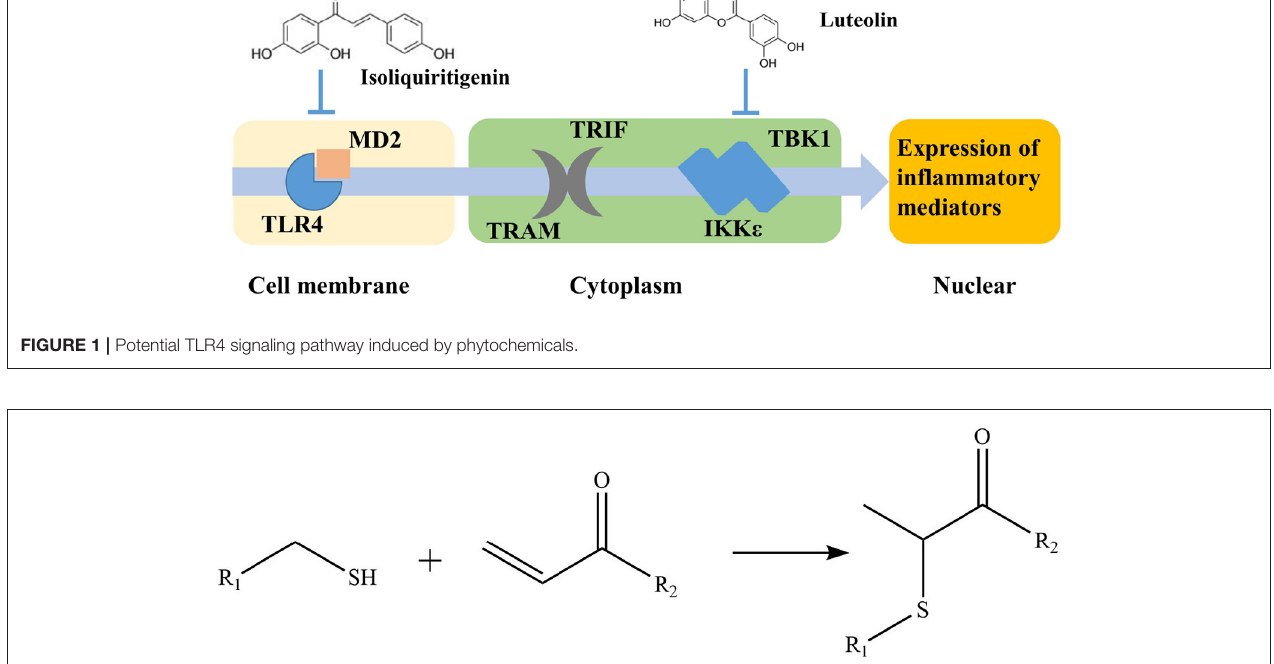
FIGURE 2 | Reaction of thiol groups in the TLR4 signaling pathway with the α , β -unsaturated carbonyl group of phytochemicals.